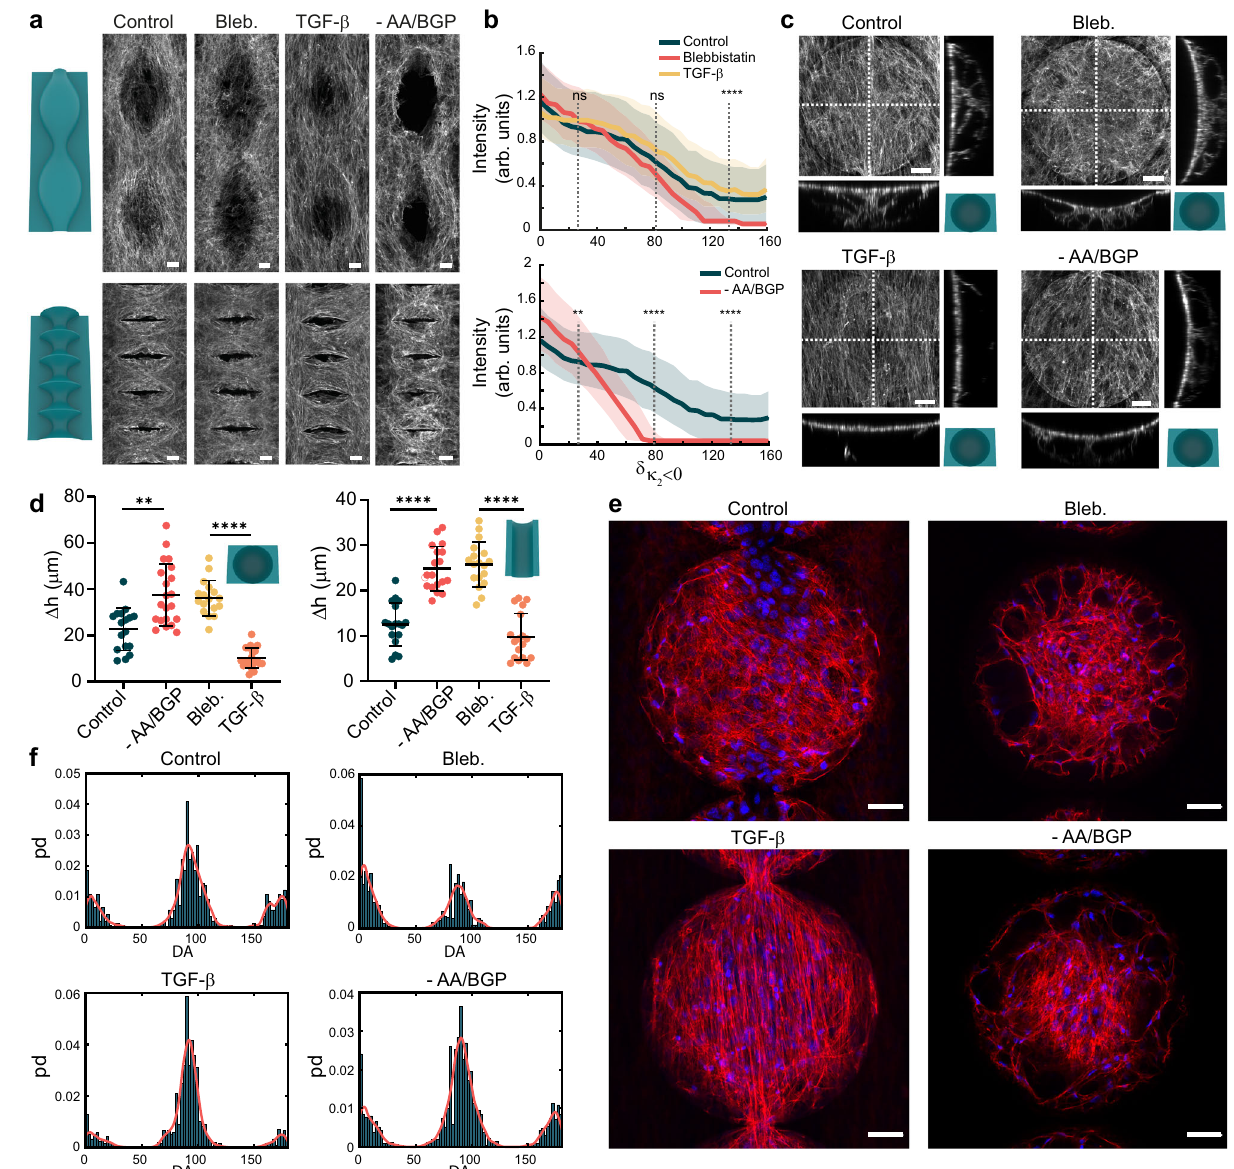
Fig.7|Effectofcontractilityanddifferentiationperturbationonthecurvature- d Quanti fi cationofcellsheetdisplacement( Δ h)duetocontractilityperturbationor induced organization. a Representative maximum intensity projections (F-actin) differentiation inhibition. Data from multiple regions on three independent on the convex unduloids (top) and catenoids (bottom), displaying the effects of experiments. Data are presented as mean values+/ − SD. Brown-Forsythe and contractility inhibition (Bleb.), contractility enhancement (TGF- β ), and differ- Welch ’ s ANOVA with Dunnett ’ s T3 multiple comparisons: ** p =0.0017, for the entiation inhibition (-AA/BGP). b Intensity reduction as a function of δ κ **** p <0.0001. e Merged F-actin (red) and DNA (blue) expression at day 8 in single 2 <0 convex spheres. The top chart demonstrates the effects of contractility perturba- slices fromz-stacks obtained onconcave sphericalwells,showing differencesinSF tion (Kruskal – Wallis test: **** p <0.0001). The bottom chart demonstrates the morphology and orientation for the different culture conditions. f PD of the SF effects of differentiation inhibition (Two-tailed Mann – Whitney test: ** p =0.0057, orientationonmaximumintensityprojectionsofconcavespheres.Datafromthree **** p <0.0001). The solid lines represent the median values while the shaded areas independent experiments. The red lines represent Epanechnikov kernel density represent the interquartile range. c Effect of contractility perturbation and differ- estimates. All scale bars are 50 μ m. Source data are provided as a Source Data fi entiation inhibition on cell sheet detachment over concave hemispheres at day 8.